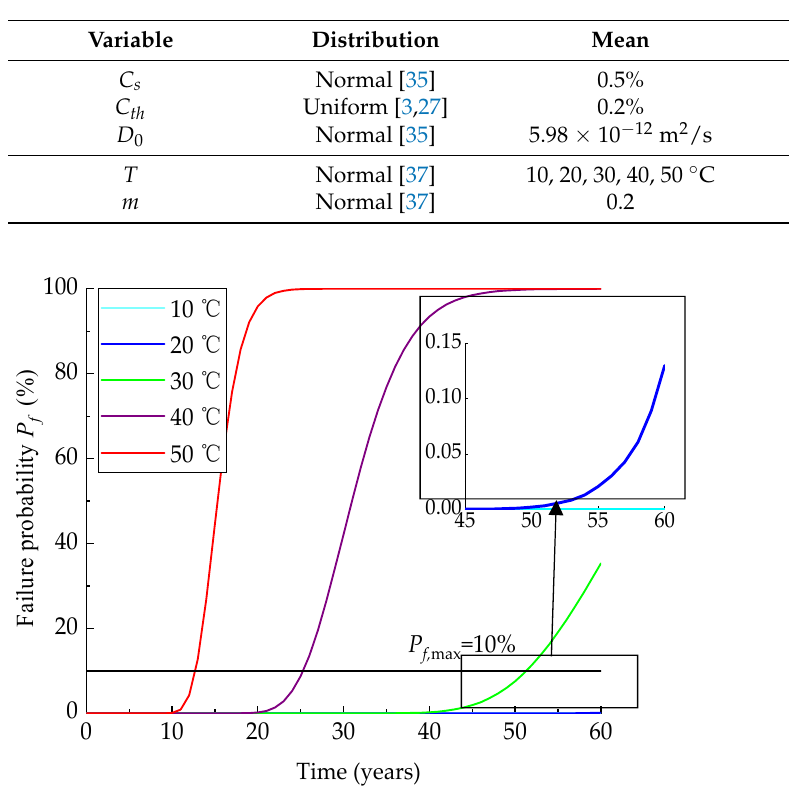
Figure 5. Variation in the failure probability of the corrosion initiation with exposure time.